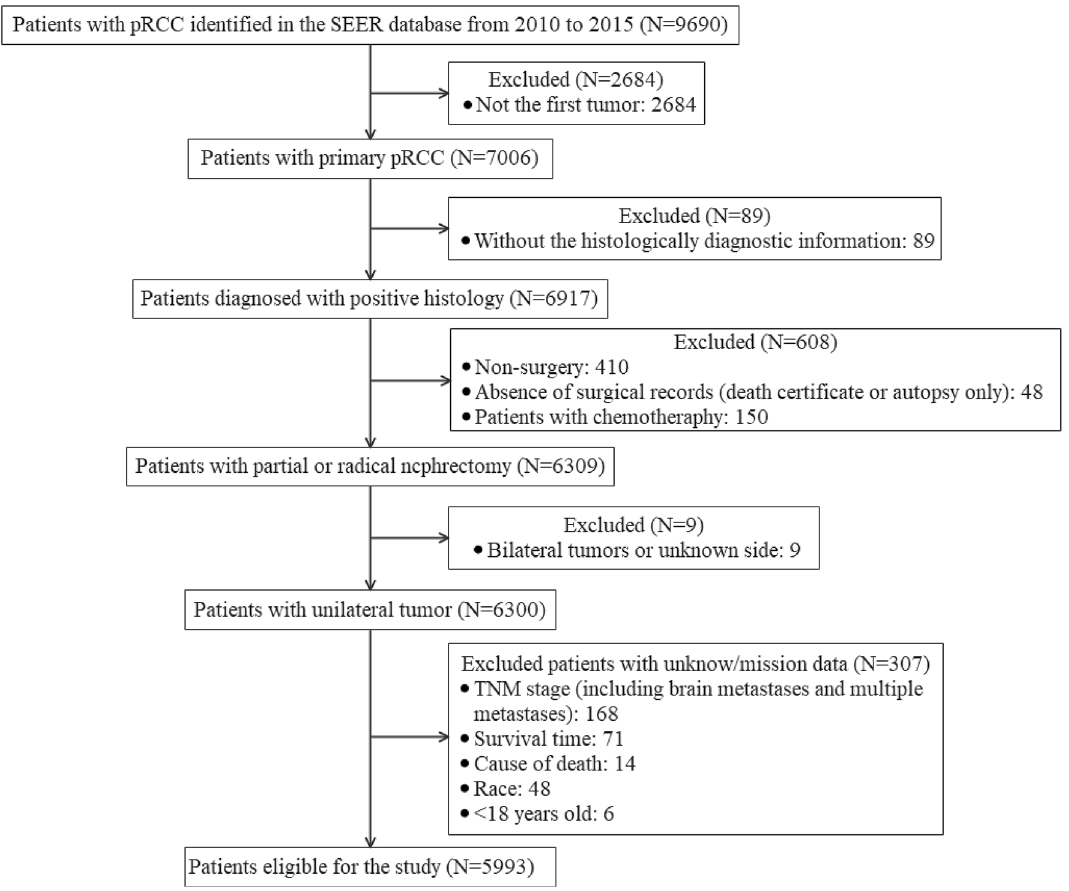
Figure 1. The flowchart of patient selection in the SEER database. pRCC papillary renal cell